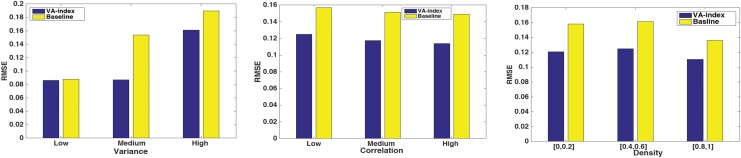
Comparison of the VA-index with the baseline extension of assortativity coefficient.The VA-index outperforms the baseline metric in all cases, irrespective of x’s elements variance, correlation and the density δ of Σ. Nevertheless, for low variance the baseline performs almost equally as good with respect to the RMSE.